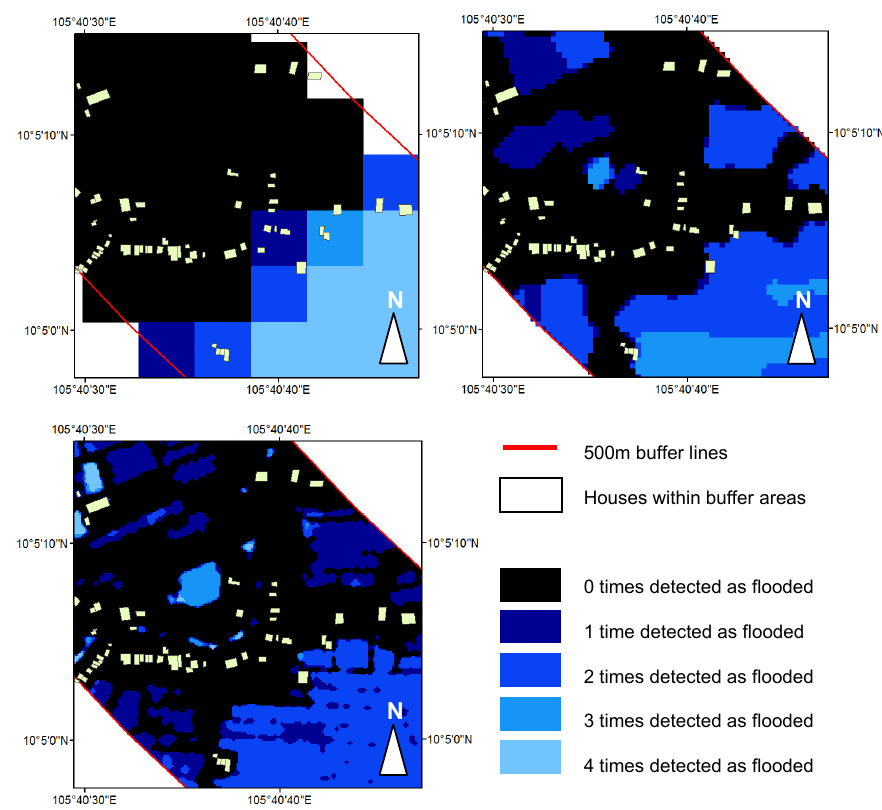
Figure 10. Zoom of flood frequency derivation of Envisat ASAR-WSM, TerraSAR-X Scansar, and TerraSAR-X Stripmap in an urban area. The subset selected for this Figure 10 is located in the center of the zoom subsets of Figure 9. The scale dependencies of water detectability as well as the problem of false alarms of flood detection become obvious.